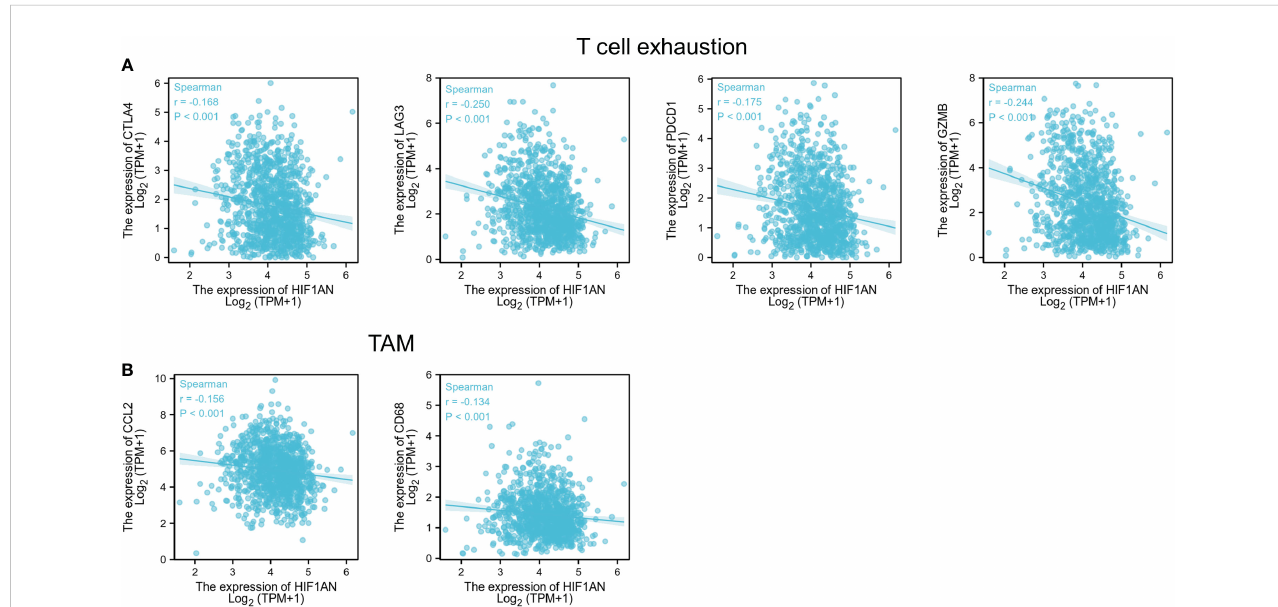
FIGURE 7 HIF1AN expression correlated with T cell exhaustion and markers include CCL2 and CD68 of TAMs in BC; Scatterplots of correlations between HIF1AN expression and gene indicators of (A) T cell exhaustion, (B) TAMs.